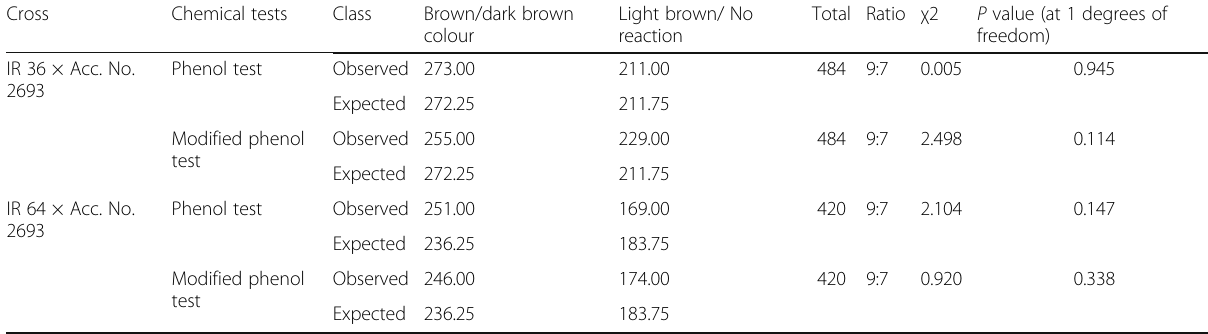
Table 2 Aleurone layer color segregation in F 2 progenies of the crosses IR 36 × Acc.No. 2693 and IR 64 × Acc. No. 2693for standard phenol and modified phenol with copper sulphate tests Cross Chemical tests